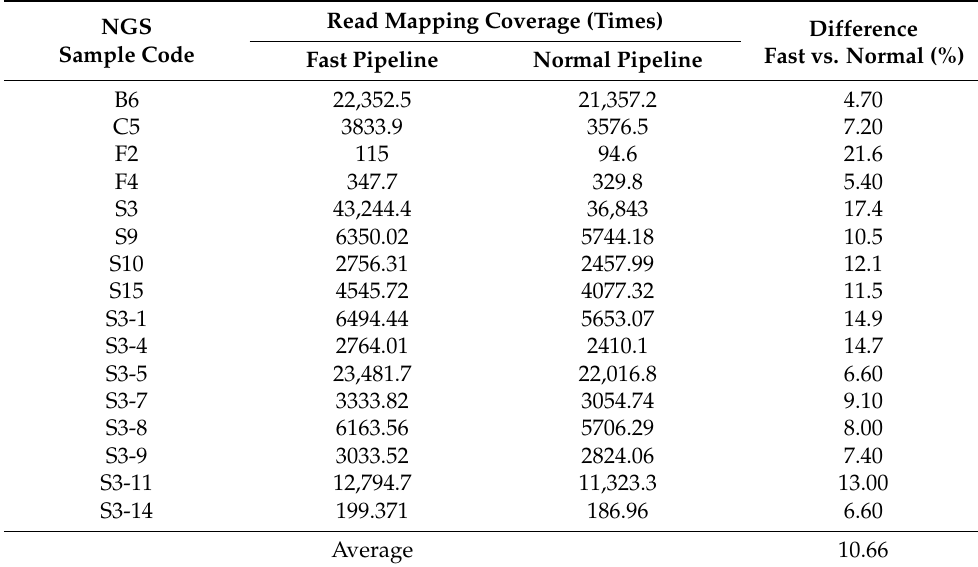
Table 6. Read mapping coverage results.